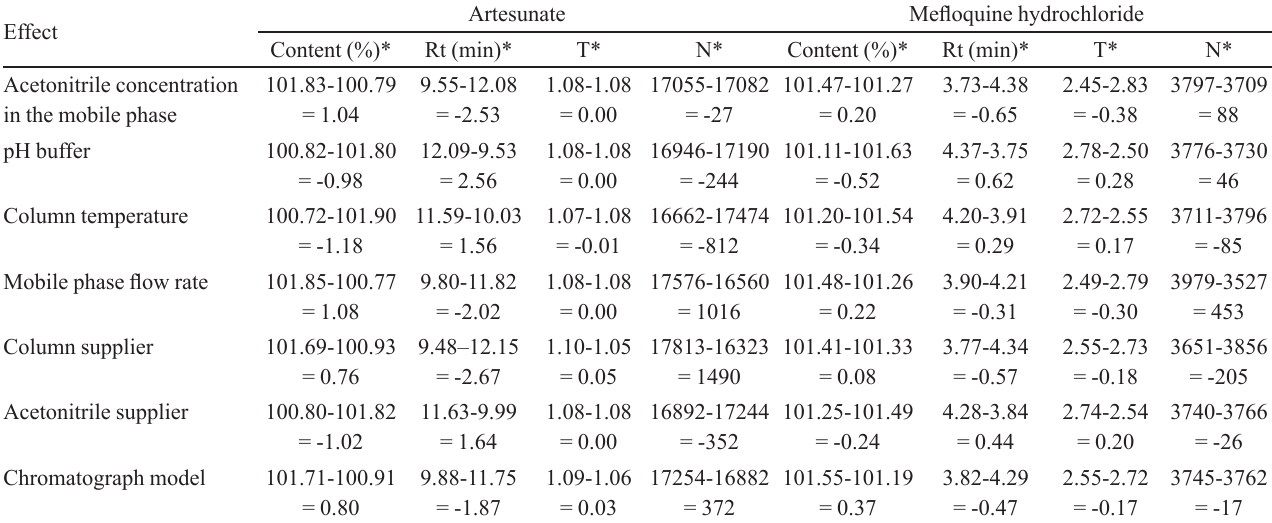
TABLE IV - Effects of the analytical parameters in content, retention time (Rt), tailing factor (T), and theoretical plate number (N) of the chromatographic method for AS and MQ quantification